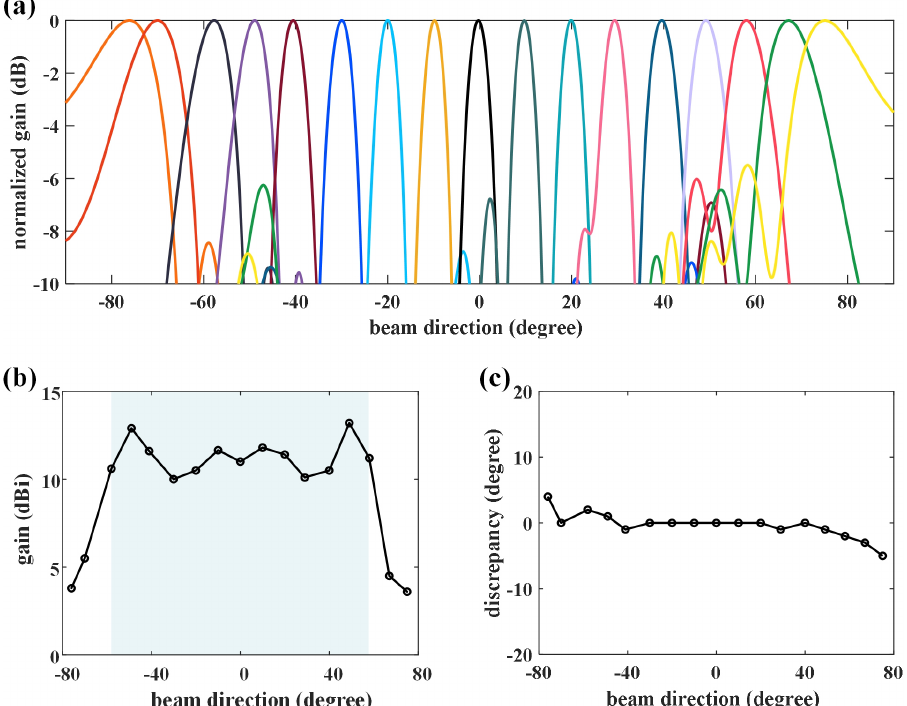
Figure 4. Beam-steerable characteristic of the graphene-biased terahertz coding meta-surface at 2.2 THz. ( a ) Radiation patterns at different scanning angle. Different colors represent different beam directions. ( b ) The gains of each beam at different radiating directions. ( c ) The discrepancy of the beam directions between the theoretical calculation and the